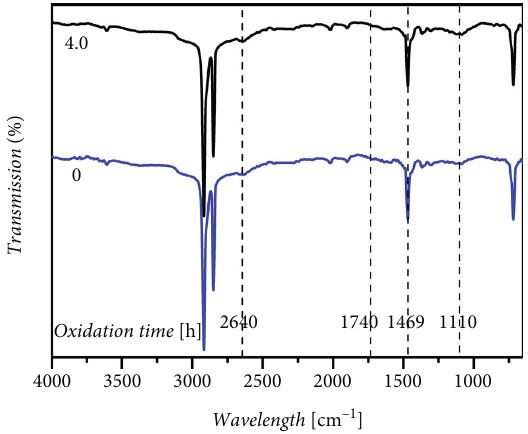
Figure 3: FTIR spectrum of unoxidized and oxidized